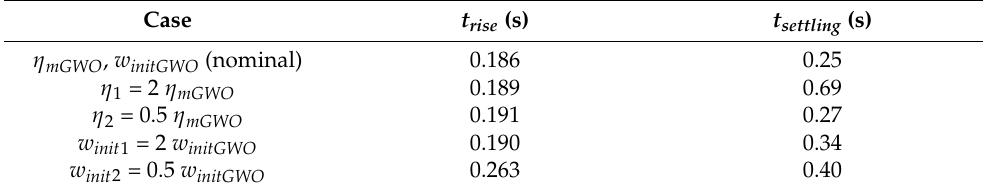
Table 3. Settling and rise times for different states of the drive.